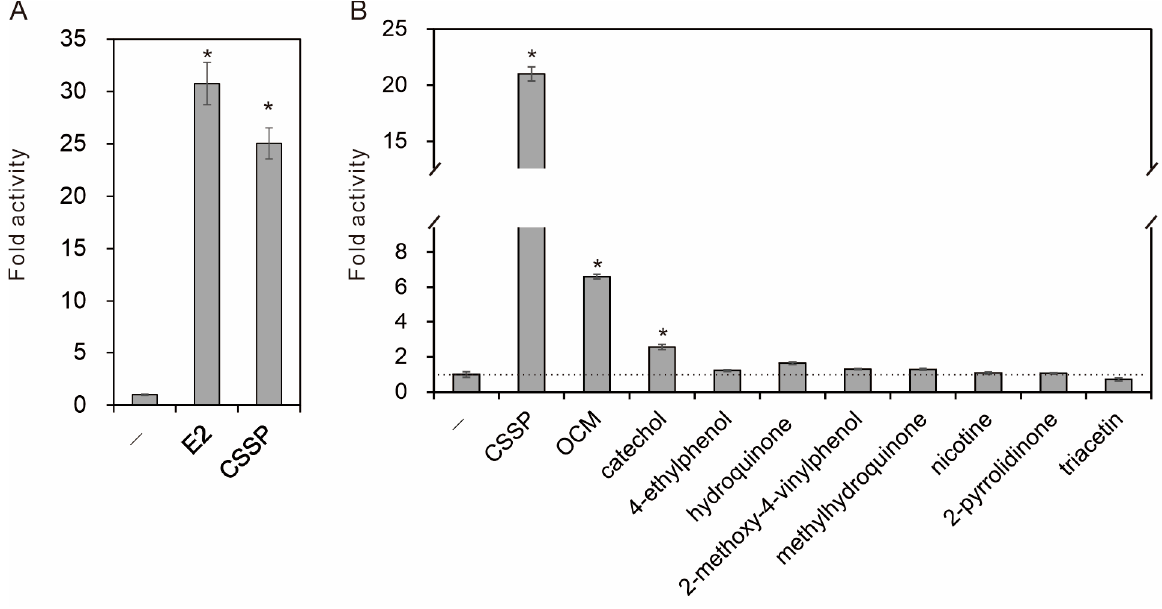
Figure 1. Estrogenic activity analysis. The estrogenic potencies of compounds and mixtures were assessed by transfection of an ERE-Luc reporter into ER α -inducible human lung adenocarcinoma cells. ( A ) The transfected cells were treated with vehicle (-), 17 β -estradiol (E2, 1 nM), and cigarette sidestream smoke particulate matter (CSSP, 20 µ g/mL) ( n = 3). ( B ) Individual components of CSSP were tested at concentrations found in CSSP alongside their reconstituted mixture (OCM) and CSSP ( n = 4). After 24 h of treatment in the presence of ER α induction, reporter activities were measured to evaluate the levels of ER α activation. All activities were compared with the vehicle control, and statistical significance ( p < 0.01) was indicated by an asterisk (*).